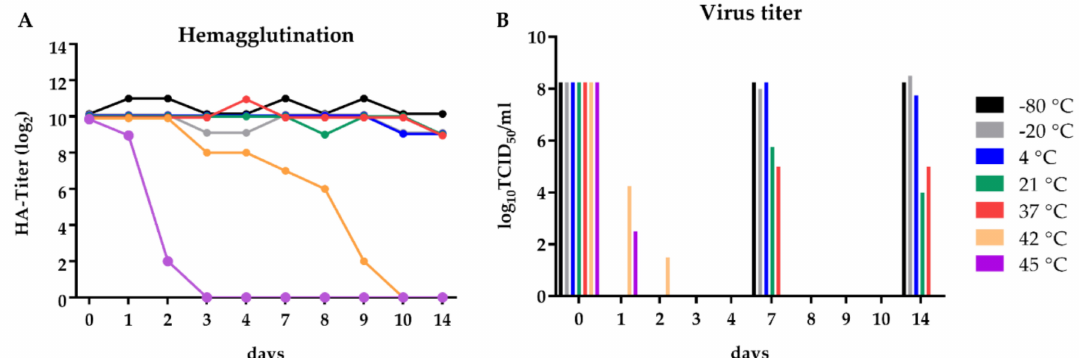
Figure 4. Investigation of thermostability of rNDV_H Kur . Aliquots of allantoic fluid containing rNDV_H Kur (500 µ L each) were stored at di ff erent temperatures ( − 80 ◦ C, − 20 ◦ C, 4 ◦ C, 21 ◦ C, 37 ◦ C, 42 ◦ C, and 45 ◦ C) for 14 days. At indicated time points, ( A ) the hemagglutination (HA) titer and ( B ) the infectious viral titers (TCID 50 / mL) were determined. The charts depict the results of a single experiment; the HA titer were determined in